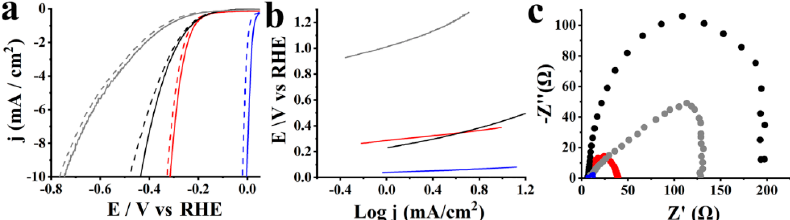
Figure 6. ( a ) LSVs, before (solid lines) and after 10,000 cycles (dashed lines) for HER, ( b ) Tafel slopes, and ( c ) Nyquist plots of S-CNHs (red), ox-CNHs (black), pristine CNHs (grey) and Pt/C (blue). The LSV polarization curves obtained at 1600 rpm rotation speed and 5 mV/s scan rate. Furthermore, to define the rate-limiting step of HER, Tafel slopes were extracted from the LSV curves (Figure 6b). Additional analysis reveals that S-CNHs present a Tafel slope of 82 mV/dec,